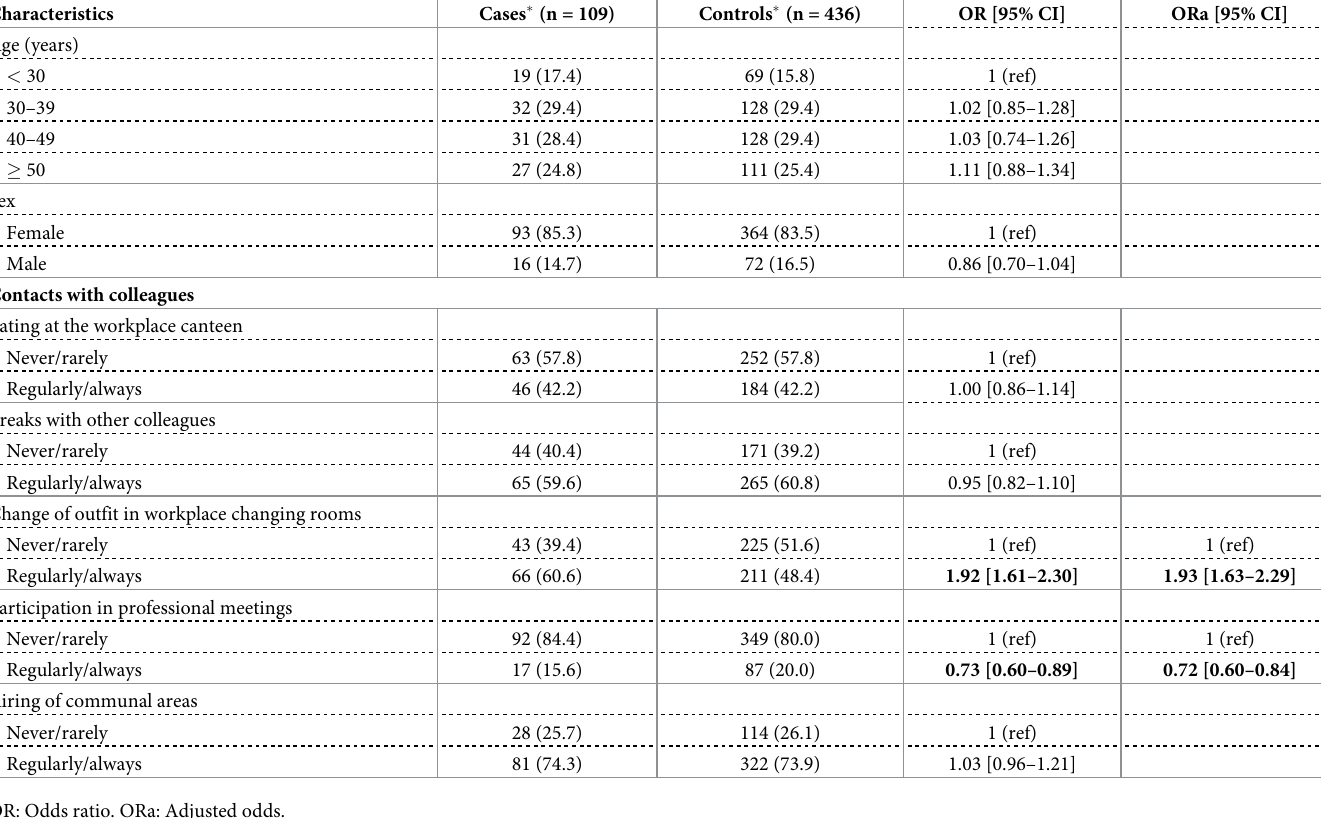
Table 4. Case-control study 3: Contacts between colleagues and airing of communal areas and risk of COVID-19 (all professions included).